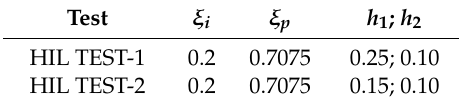
Table 6. P av and Q av parameters for the hardware-in-loop (HIL)